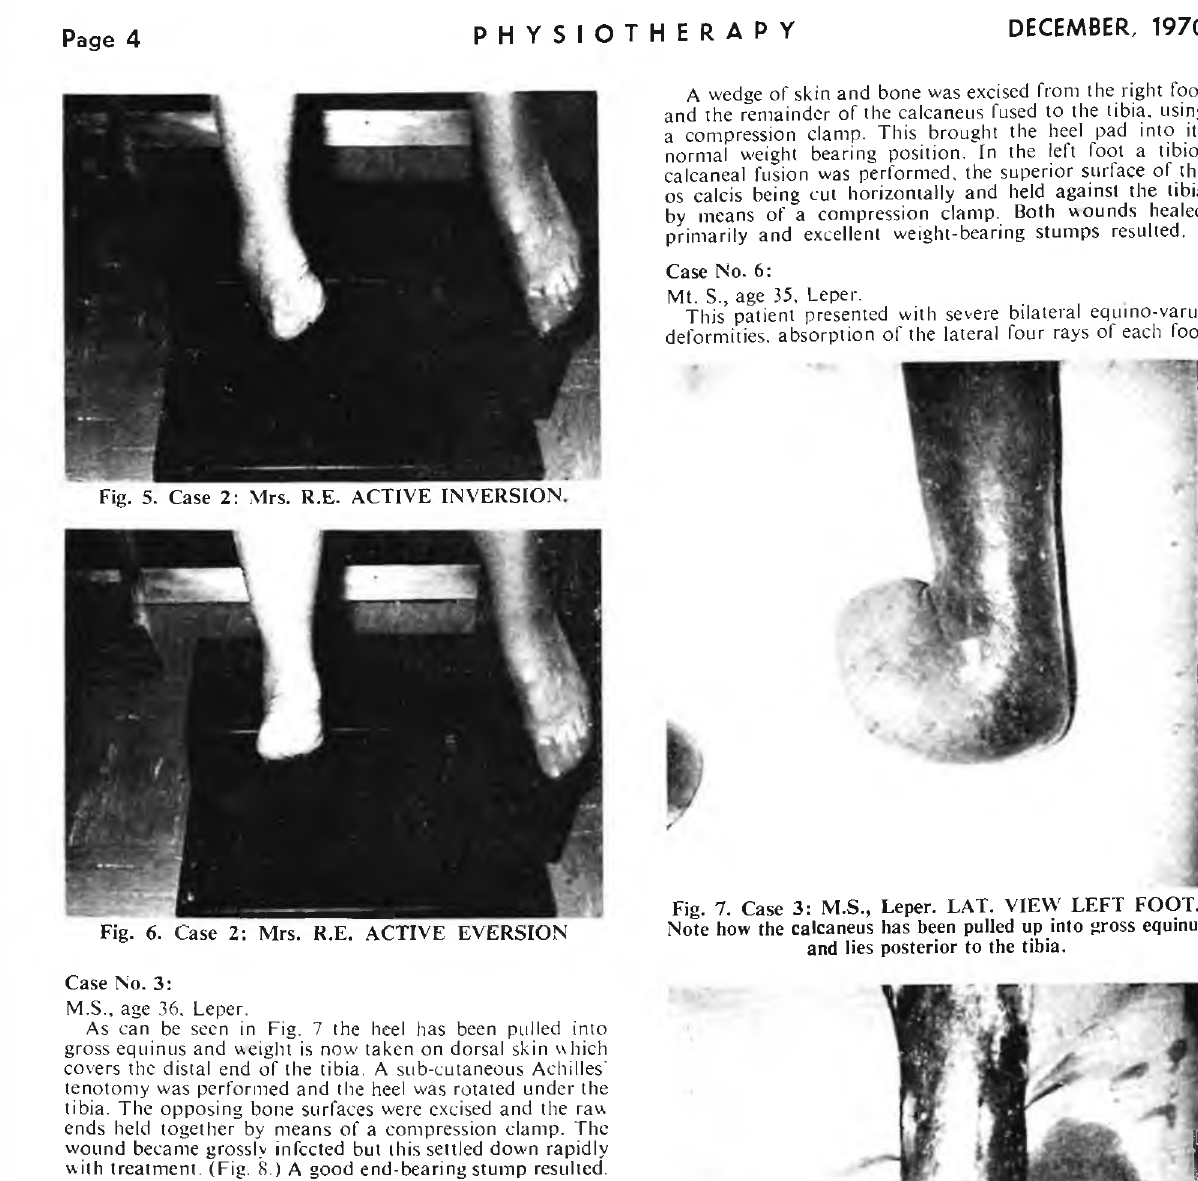
Fig. 6. Case 2 : Mrs. R.E. ACTIVE EVERSION